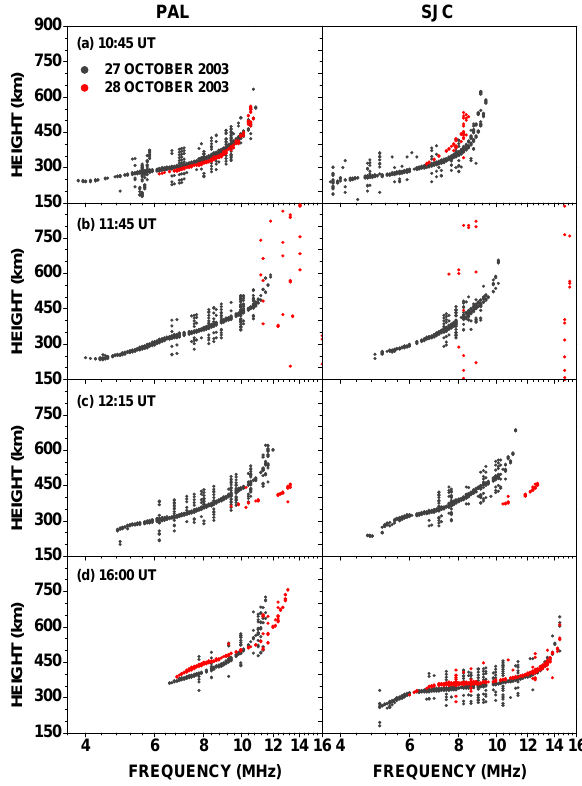
FIGURE 4 Fig. 4. The ionograms obtained at (a) 10:45 UT, (b) 11:45 UT, (c) 12:15 UT and (d) 16:00 UT on 27 October 2003 (normal day; black dots) and 28 October 2003 (solar flare day; red dots) at PAL and SJC. This period covers the ionograms obtained with partial radio wave absorption at 10:45, 12:15, and 16:00 UT and complete absorption at 11:45